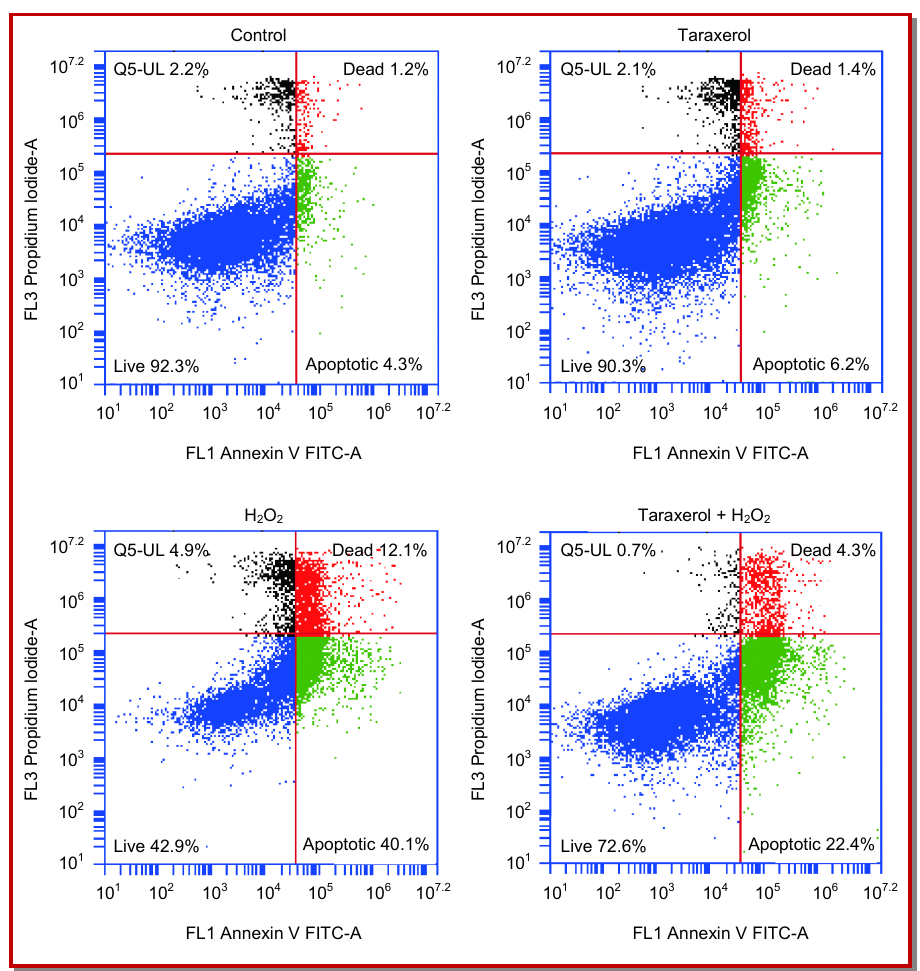
Figure 3: Taraxerol protects L02 cells from H 2 O 2 -induced apoptosis. After treated with taraxerol or H 2 O 2 for 12 hours, L02 cells were dyed with both of annexin-V/FITC and propidine iodide (PI). Flow cytometric analysis was performed with BD Accuri C6 Software